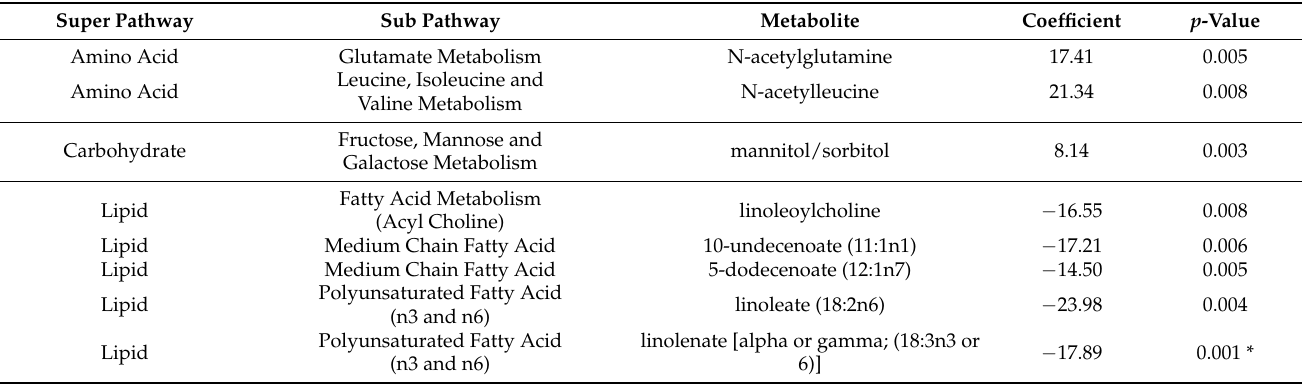
Table 2. Metabolites associated with RIT ( p -value <